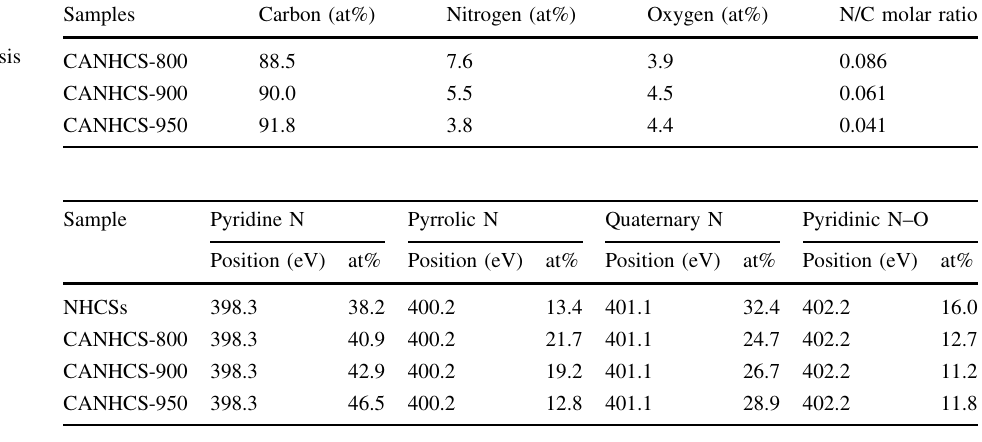
groups are doped including pyridinic N, pyrrolic N, qua- ternary N and pyridinic N–O which center at * 398.3, * 400.2, * 401.1, and * 402.2 eV for binding energy,